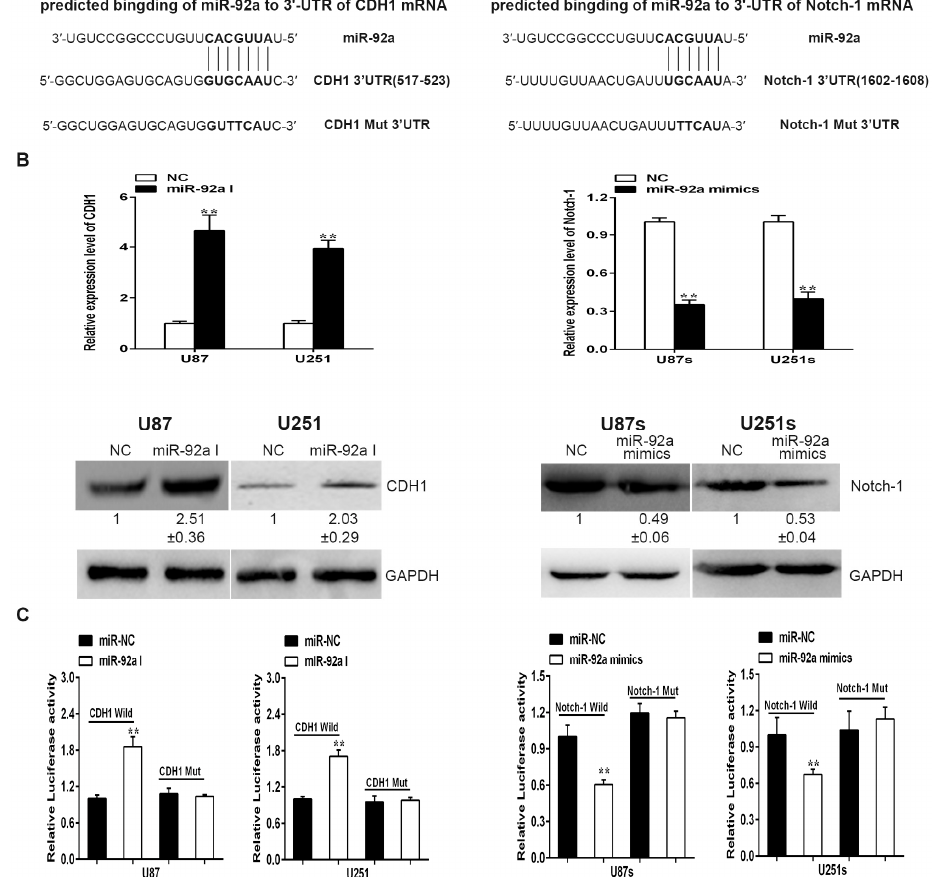
Figure 4. CDH1 and Notch-1 are direct targets of miR-92a-3p in glioma cells and GSCs, respectively. ( A ) Targeting sequences and mutated nucleotides of miR-92a-3p in 3 ′ UTR of CDH1 and Notch-1; ( B ) The mRNA and protein expression levels of CDH1 in glioma cells and Nocth-1 in GSCs were evaluated by qRT-PCR and Western blotting; ( C ) Relative luciferase activity of wild-type 3 ′ UTR and mutant type 3 ′ UTR of CDH1 and Notch-1. Each bar represents the mean of three independent experiments. ** indicates p < 0.01.